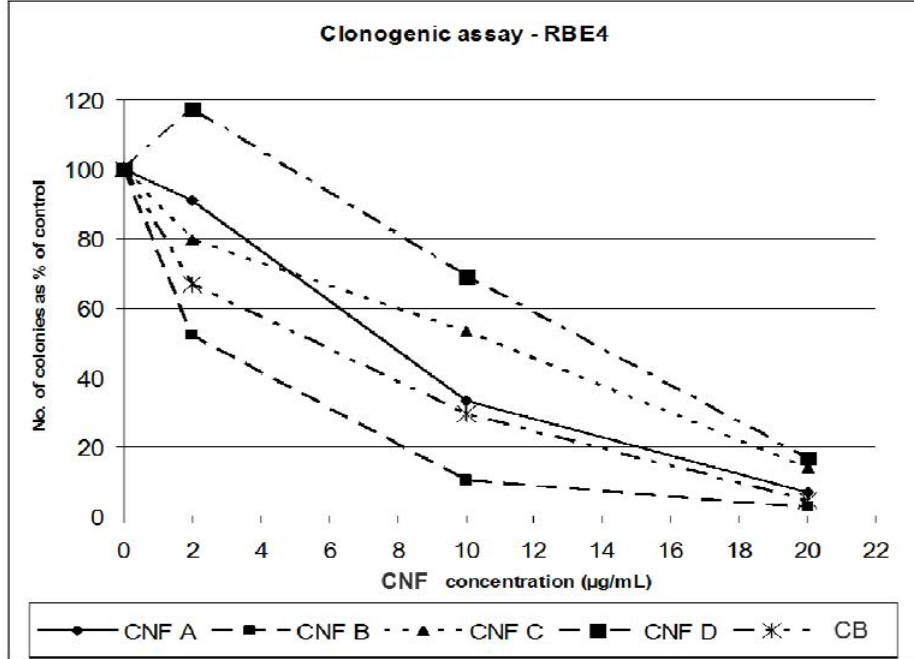
Figure 6. Reduction in RBE4 colony formation after exposure for five days to four different CNF samples. CB included as reference. Bars indicating reproducibility have not been included—please refer to Table